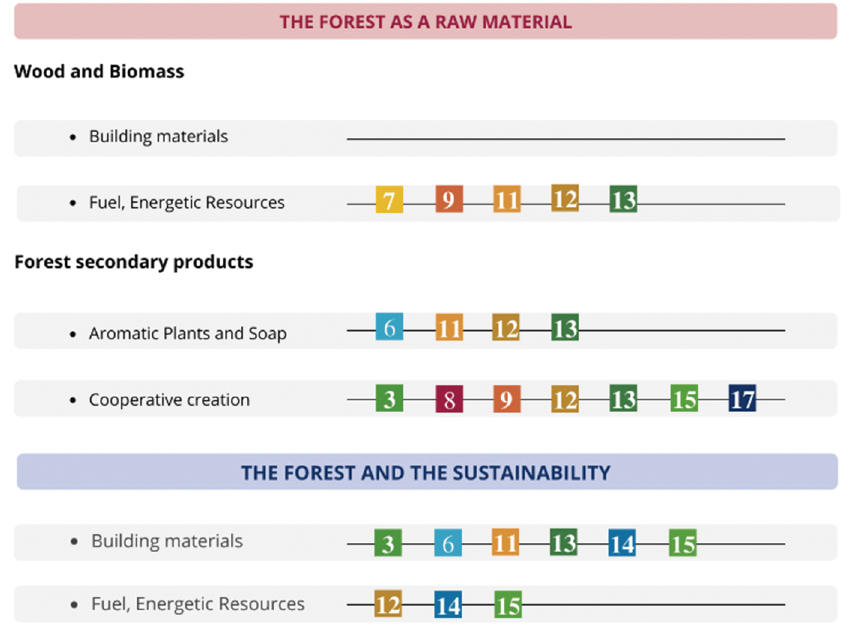
Figure 9. Relationship between forests and the SDG. Original creation